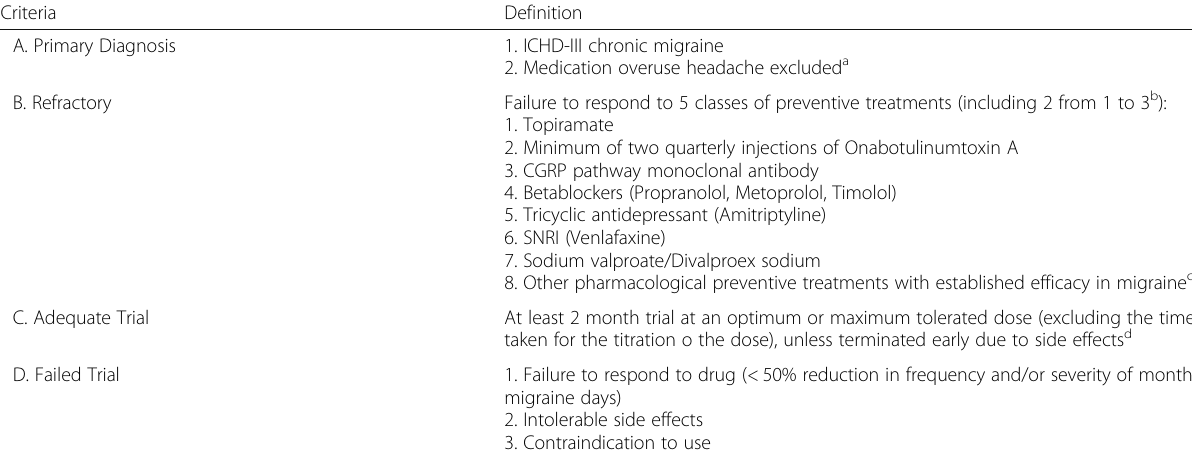
Table 2 Proposed criteria for refractory chronic